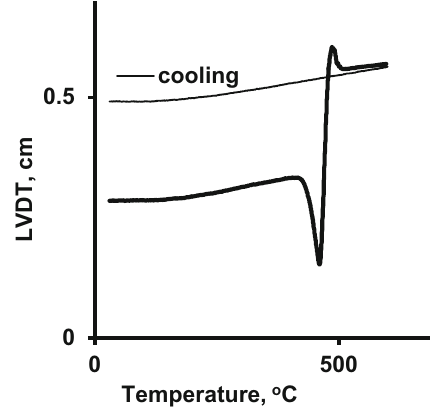
Fig. 3 Coal dilation phases: softening/plasticization, thermal decom- position and gas evolution, re-solidification and cooling (Pocahontas No.